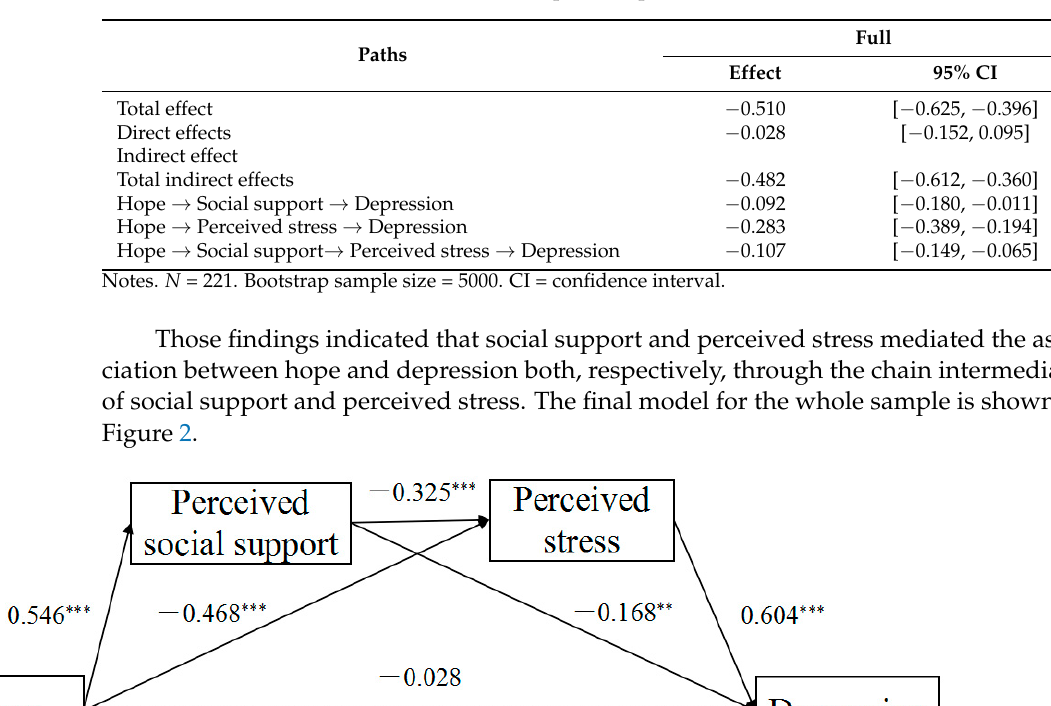
Table 4. Total, direct and indirect effects of hope on depression.